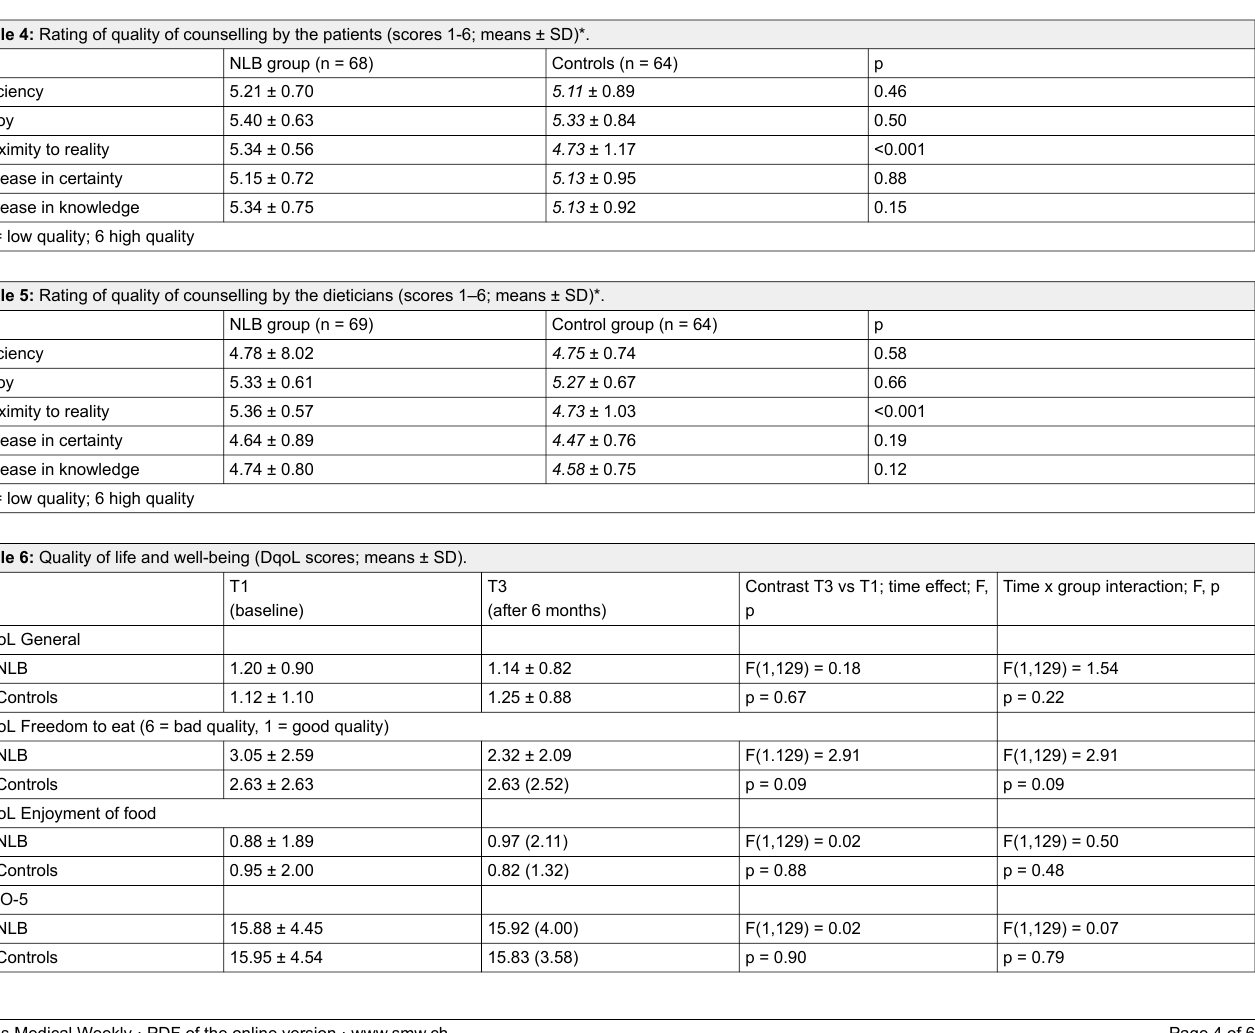
Table 4: Rating of quality of counselling by the patients (scores 1-6; means ± SD)*.